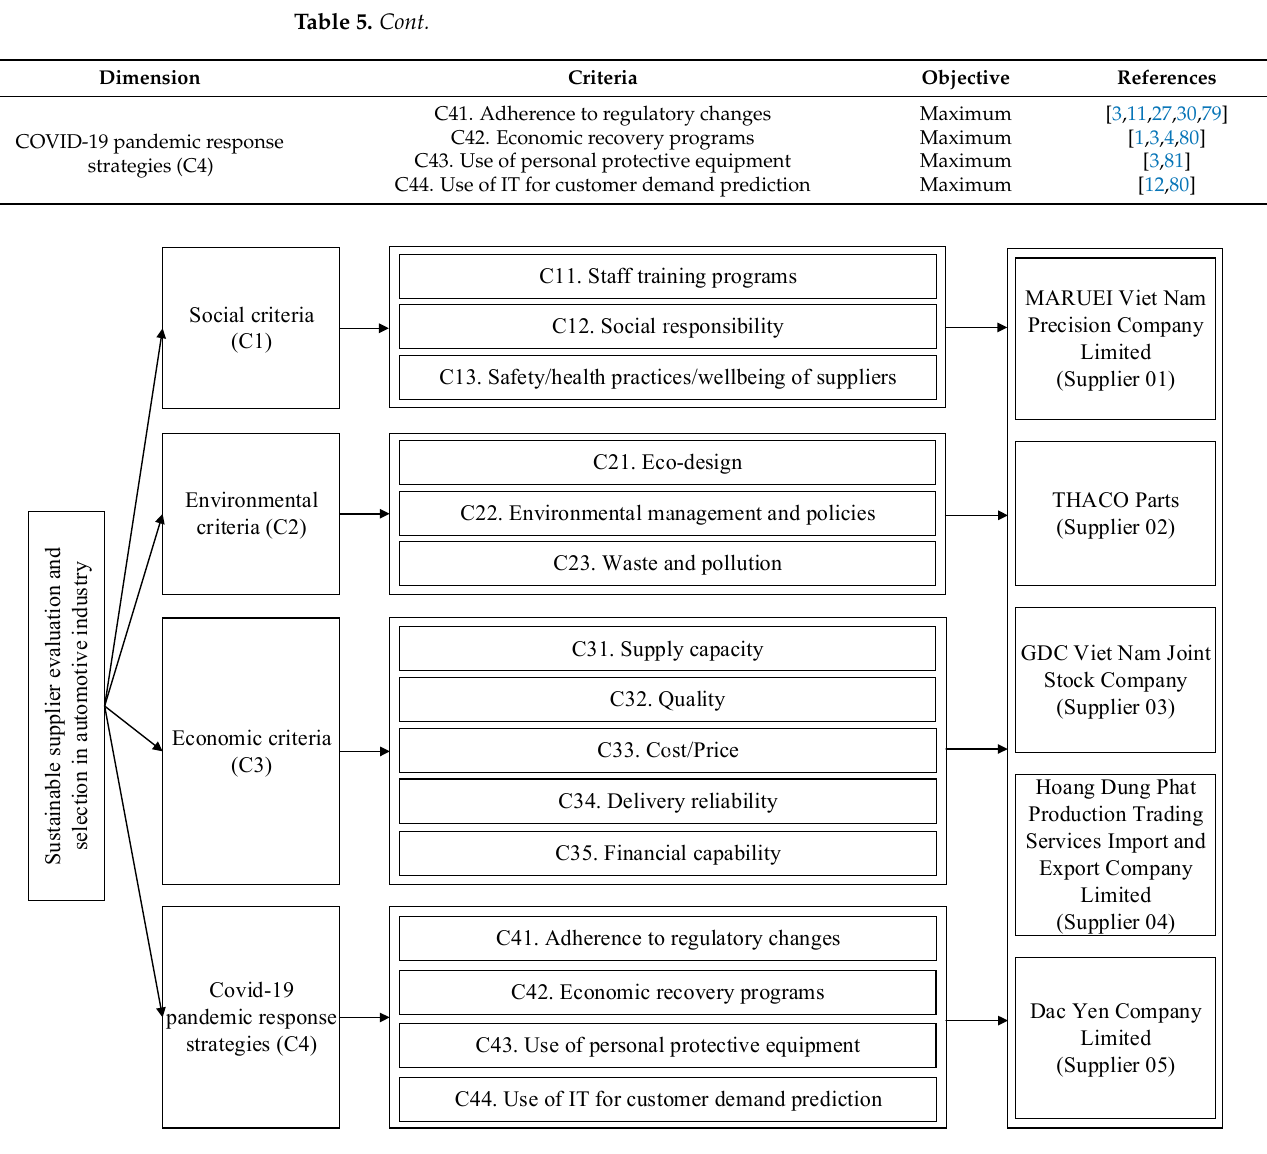
Figure 2. Hierarchical structure.